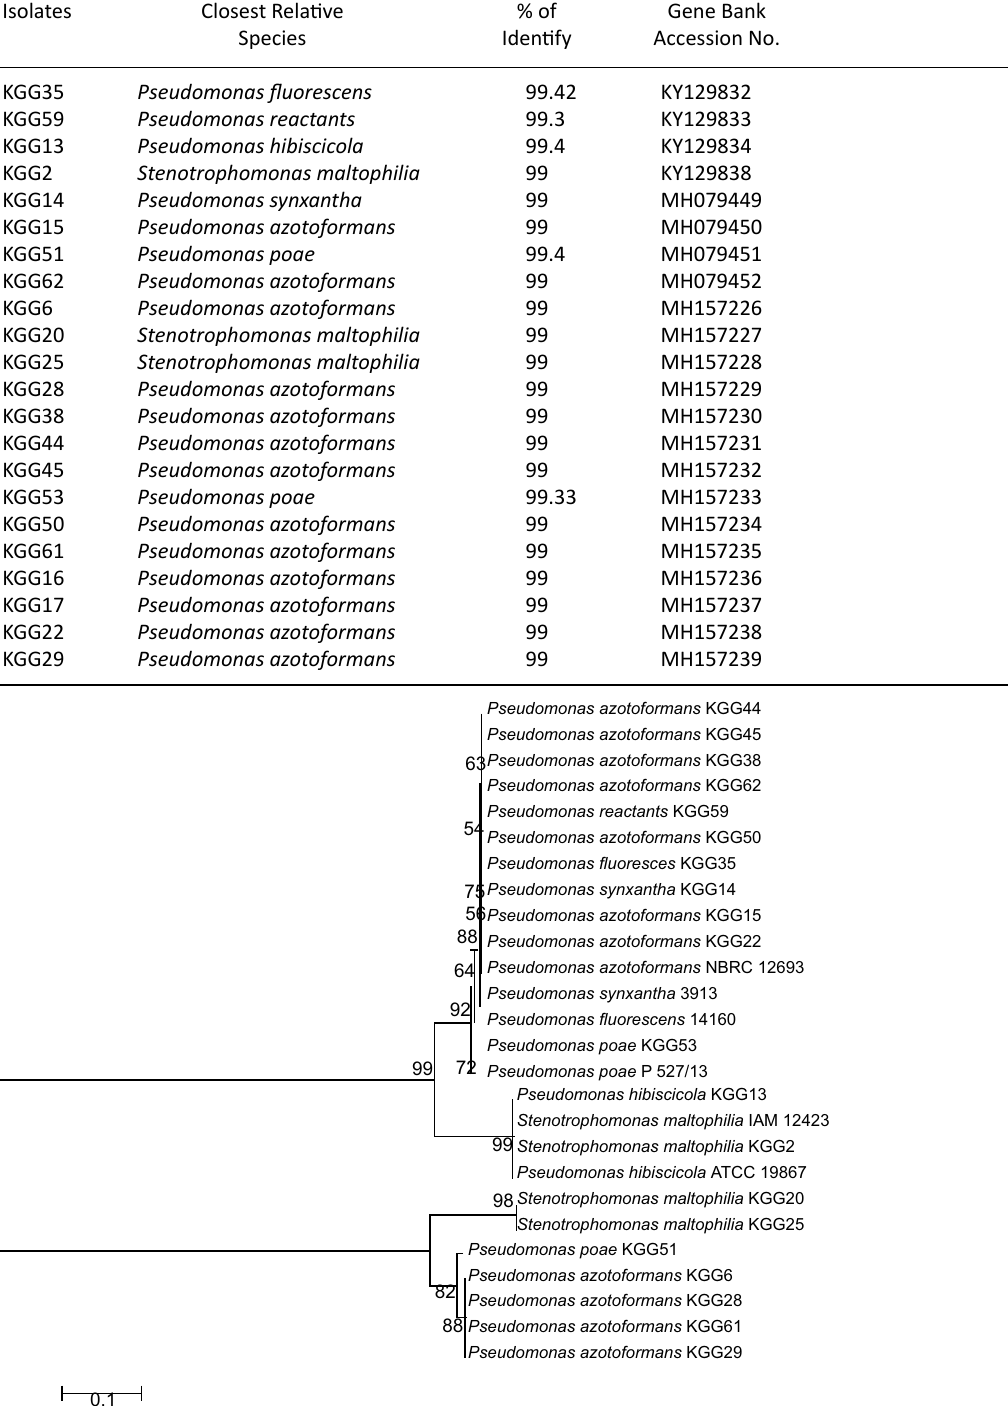
Table 5. Identification of the bacterial isolates through GenBank 16S rRNA gene sequence accession